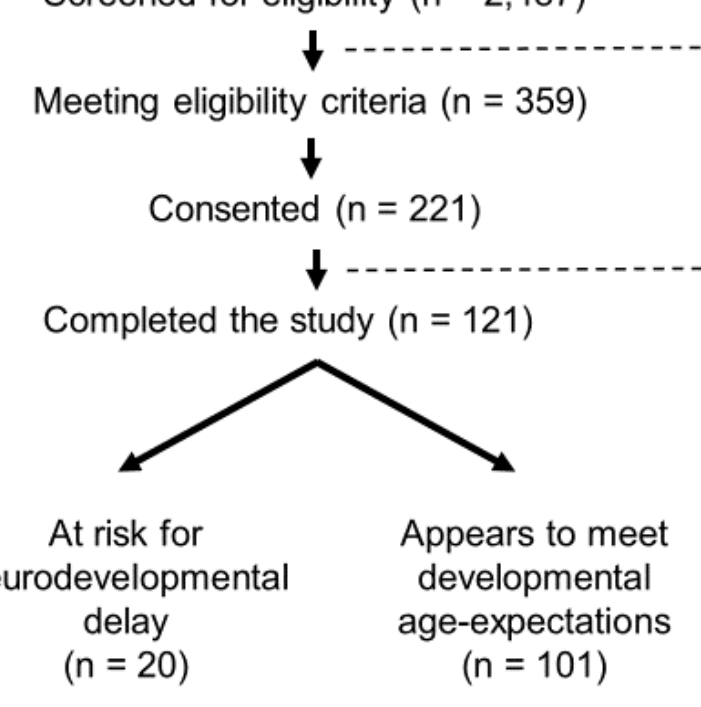
Figure 4. There were 2487 mother–infant dyads screened, 359 eligible dyads approached, and 221 dyads consented. There were 121 infants for whom 6-month saliva samples were available and neurodevelopmental status could be confirmed at 18 months. Pediatricians used the Survey of Wellbeing in Young Children (SWYC) to aid identification of 20 infants as “at risk for neurodevelopmental delay”, and identify 101 infants who “appeared to meet developmental age expectations”. SWYC scores and pediatrician assessments were extracted from the electronic medical record by research